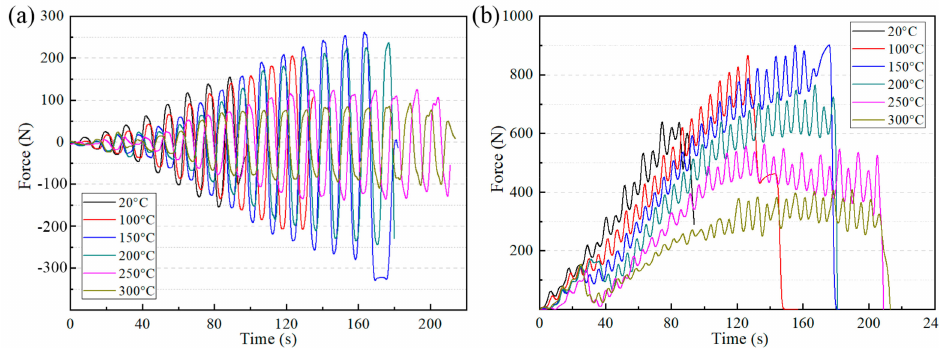
Figure 6. ( a ) Horizontal forming forces and ( b ) vertical forming